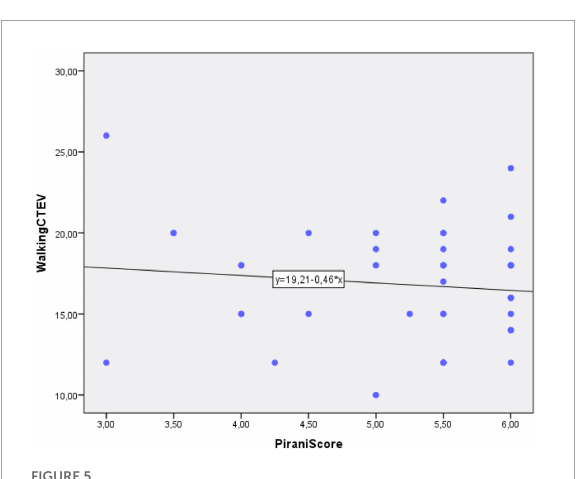
FIGURE5 Correlation between independent gait and Pirani score.